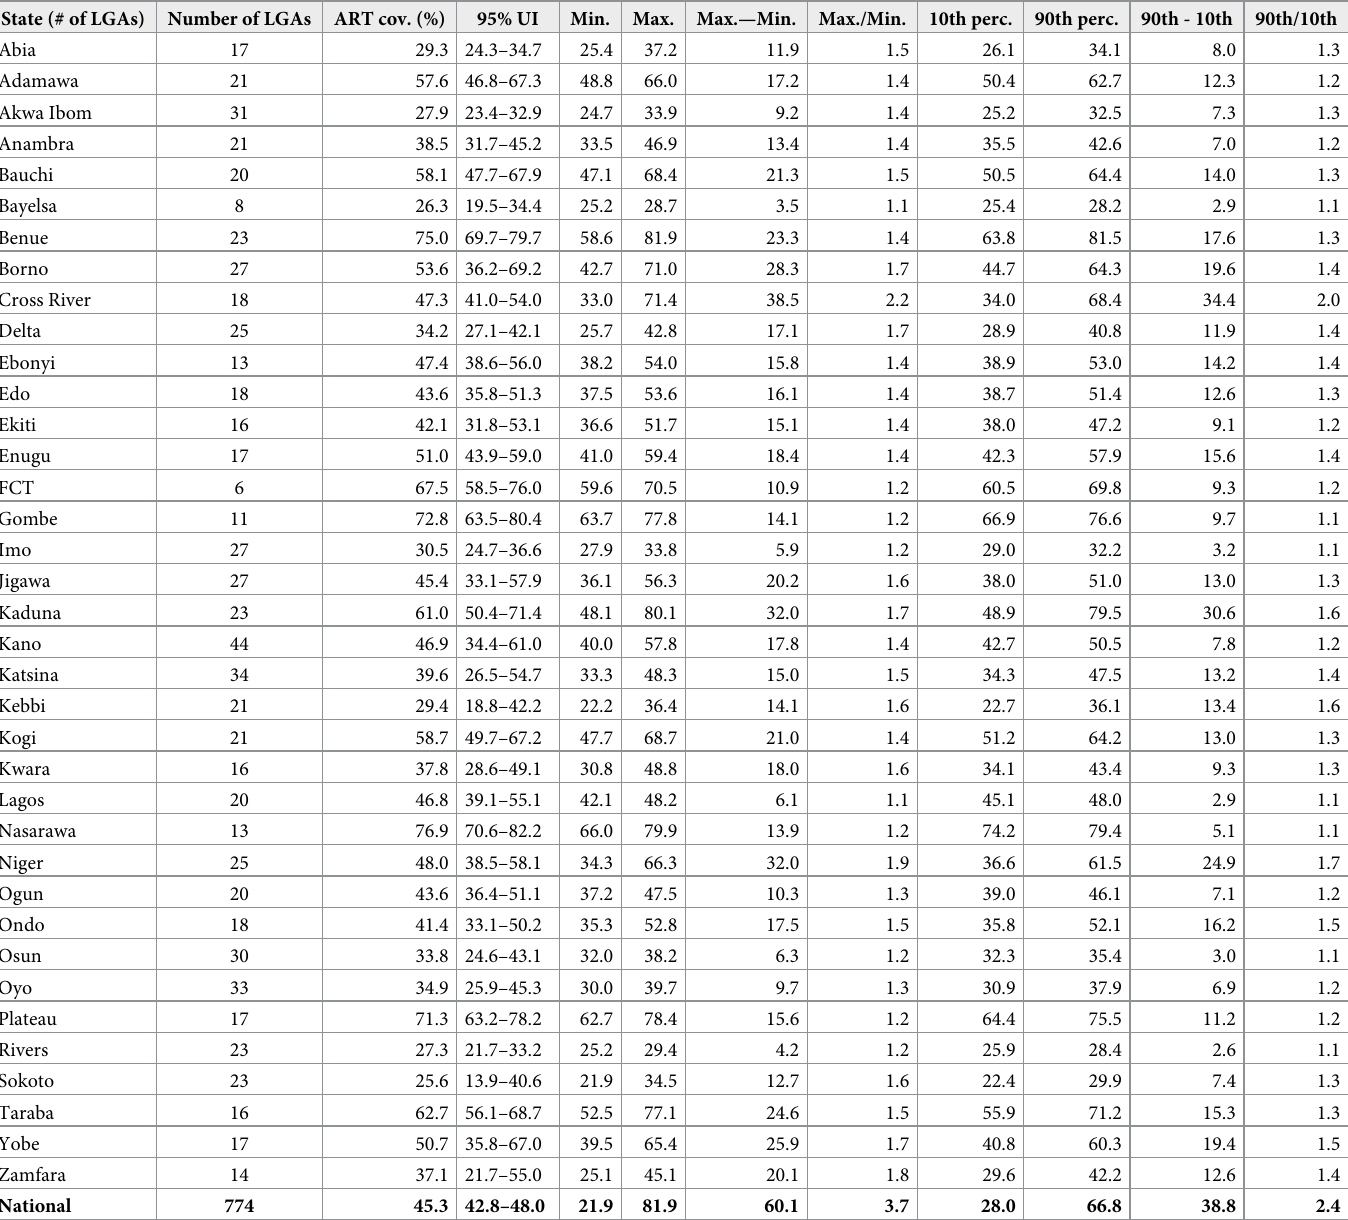
Table 4. Differences in antiretroviral therapy coverage among people living with HIV between local government areas within states in Nigeria (2018). State (# of LGAs) Number of LGAs ART cov.